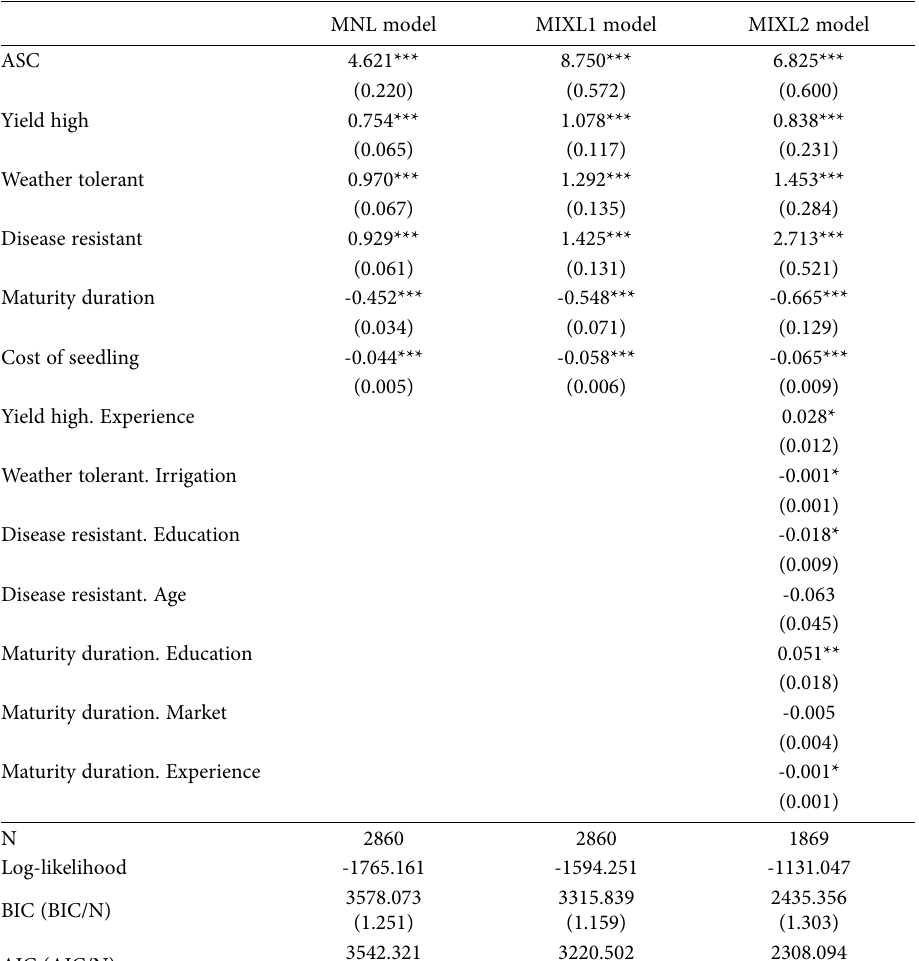
Table 4. Results of the MNL model and MIXL models without (MIXL1) and with (MIXL2) sociodemo- graphic determinants of preferences